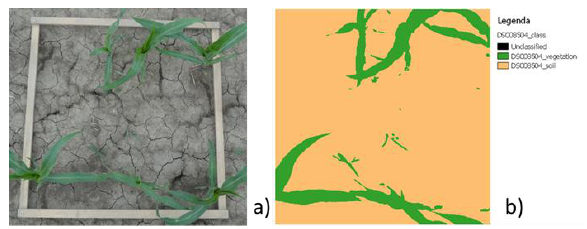
Figure 4. a) In situ RGB photo and b) SVM classification for the estimation of ground fractional vegetation cover; only pixels inside the 0.5 m 2 frame are